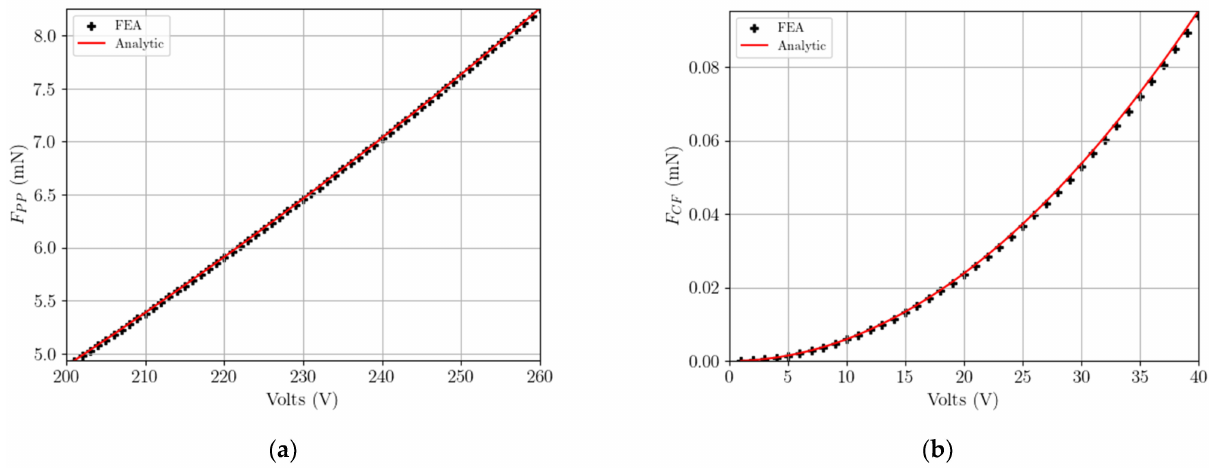
Figure 2. Comparison between analytical and numerical solutions, in terms of the electrostatic forces ( a ) F PP and ( b ) F CF as functions of the applied